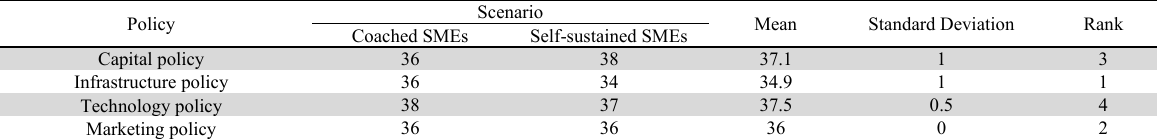
Score of Policy Against Scenario